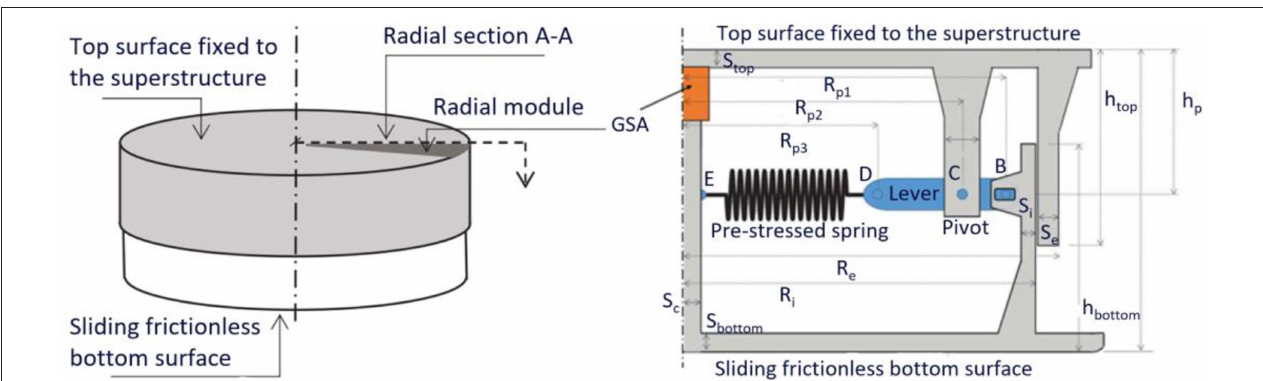
FIGURE 3 | The 3D structural diagram and the mathematical model of the inclined lead rubber bearings (Liu et al., 2018b).